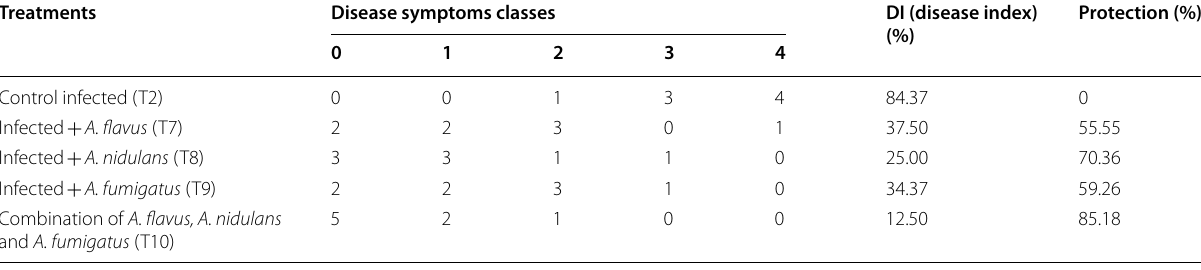
Table 2 Effect of fungal ethyl acetate extracts on DI of infected Tomato plants Treatments Disease symptoms classes